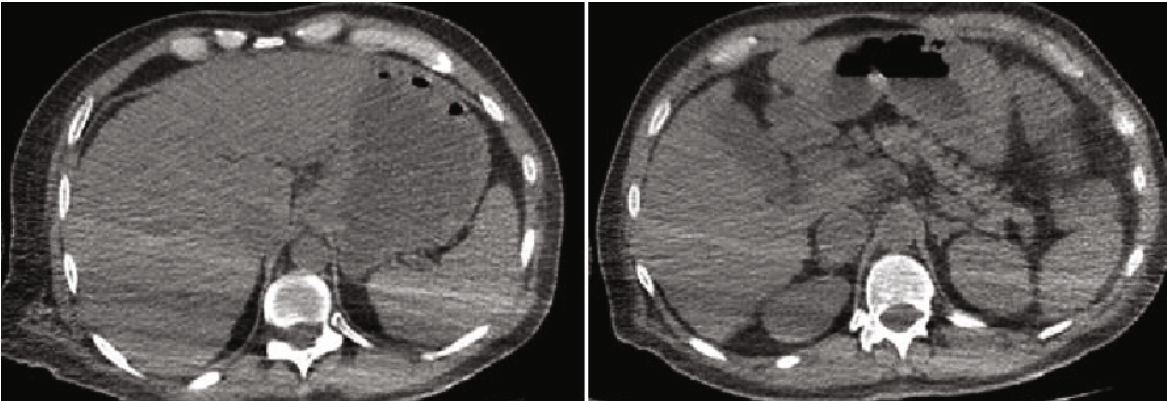
Figure 1: Abdomen CT scan showing a normal liver.